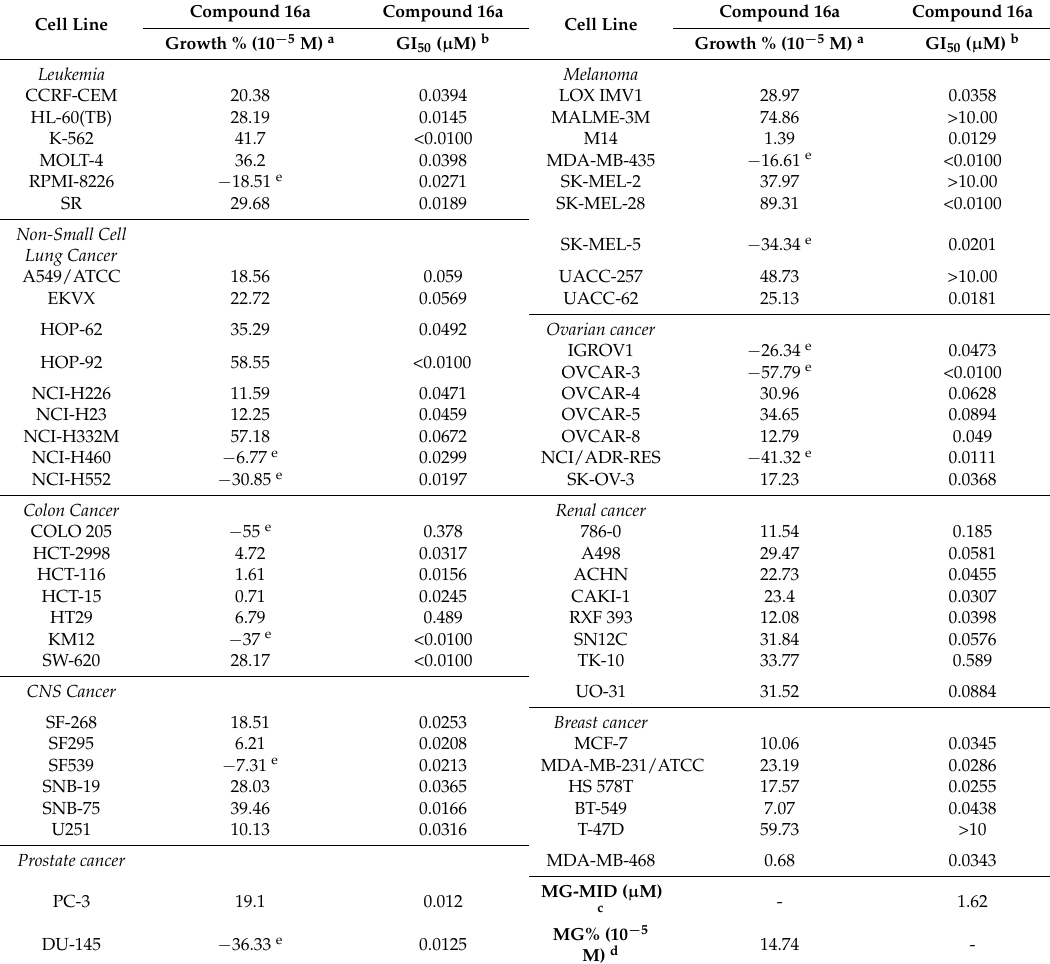
Table 4. In vitro human cancer cell growth inhibition for compound 16a a : Antiproliferative evaluation in the NCI60 cell line in vitro